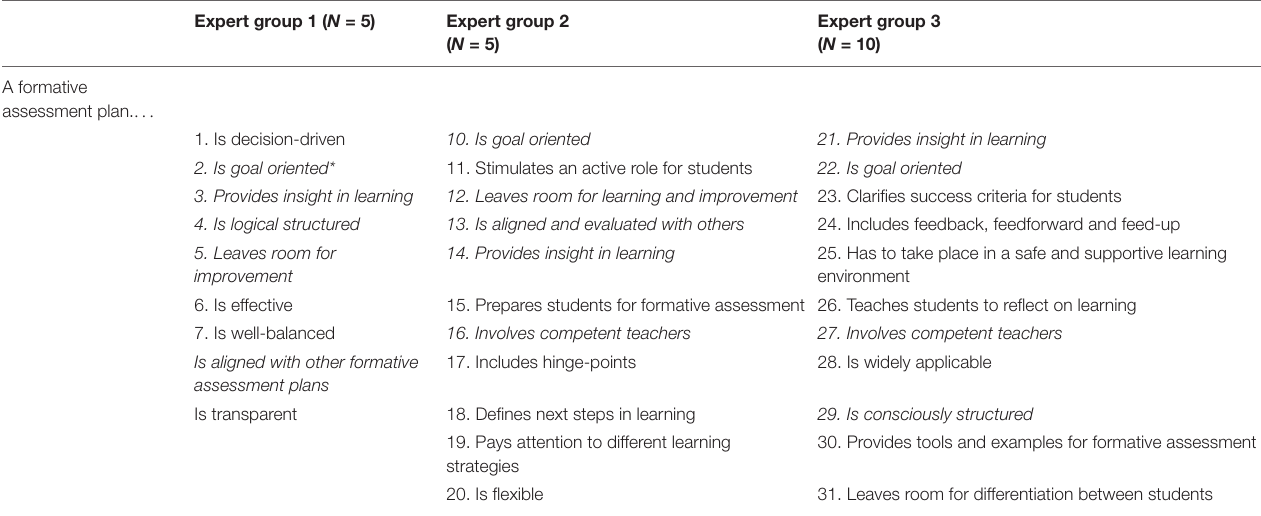
TABLE 4 | Results of expert interviews: 31 features, presented per expert group and ranked in order of importance by the participants. Expert group 1 ( N =